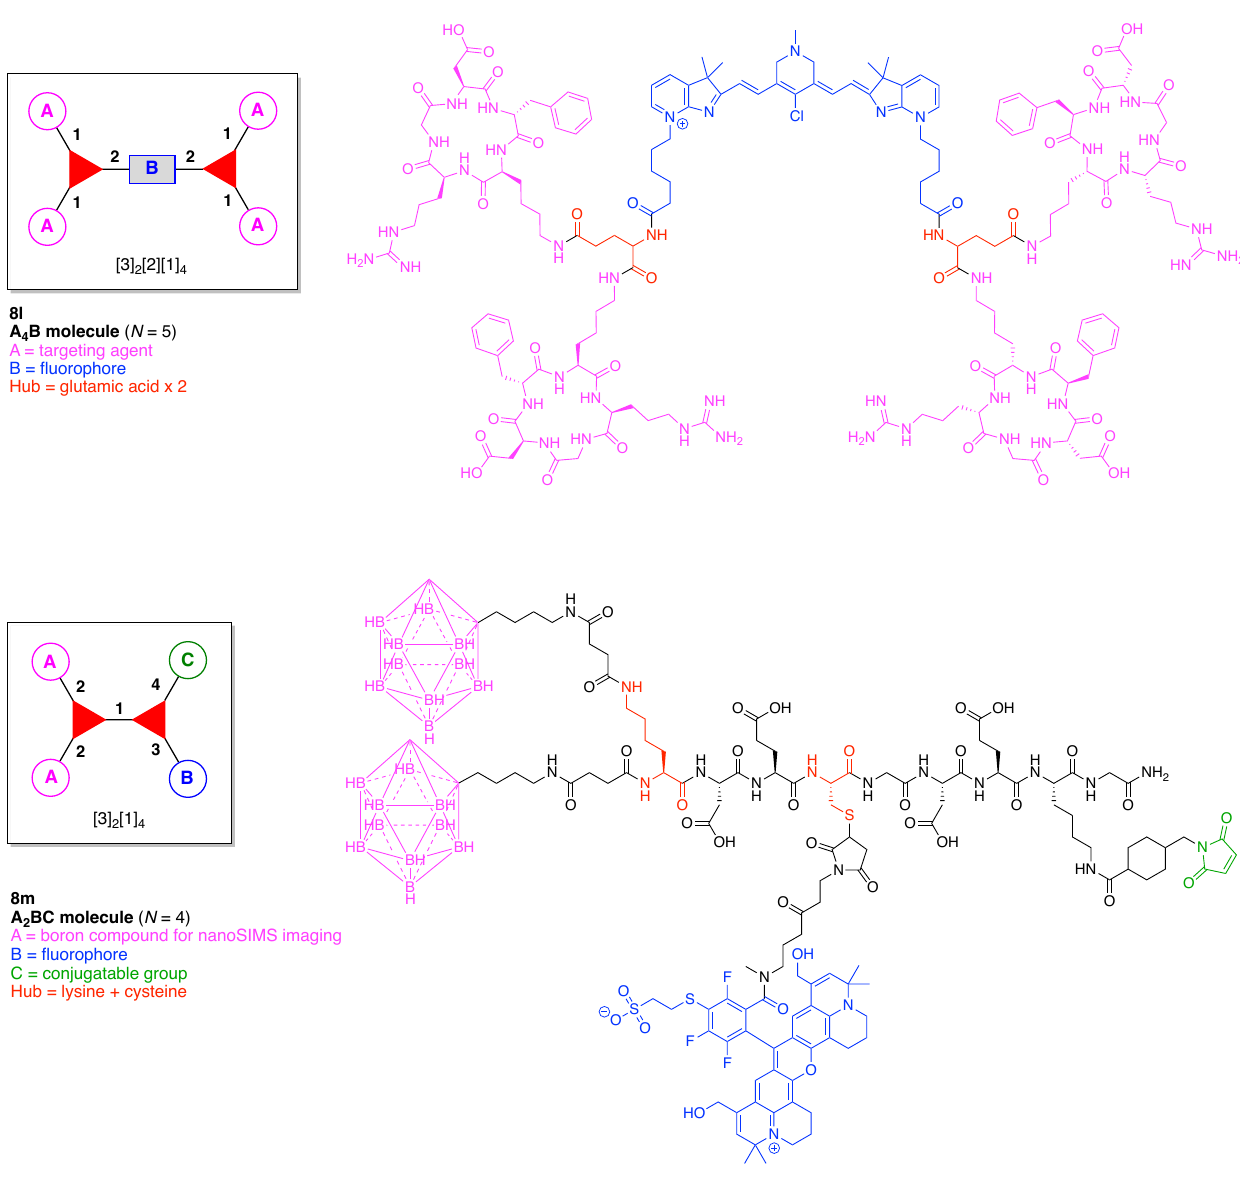
(Figure 29) [171]. The probe is comprised of two hubs (Lys and Cys) and three func- tional components: (A) an o -carborane unit, which exhibits a strong signal in nanoSIMS; (B) Star635 as a fluorophore, and (C) a maleimide for conjugation with a Cys residue. This construct ( 8m ) has composition A 2 BC and architecture [3] 2 [1] 4 . The carborane probe is ini- tially coupled with an ectopic cysteine of a nanobody through a standard thiol–maleimide reaction. The probe-nanobody conjugate is then bound to target proteins on the cells via their epitopes to achieve cellular immunostaining, followed by nanoSIMS imaging of specific target proteins.